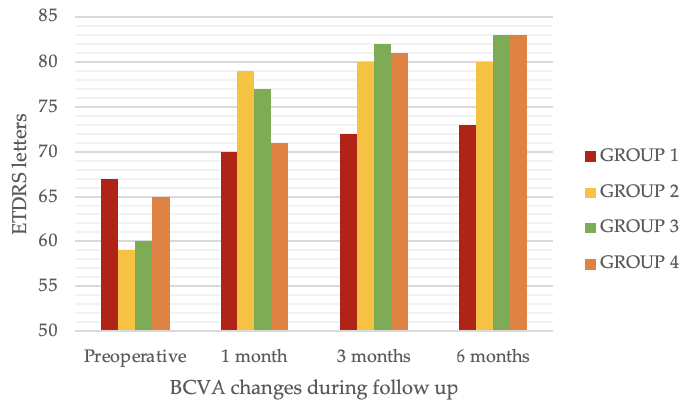
Figure 2. Changes in BCVA during the follow-up for each of the 4 groups. BCVA = best corrected visual acuity.